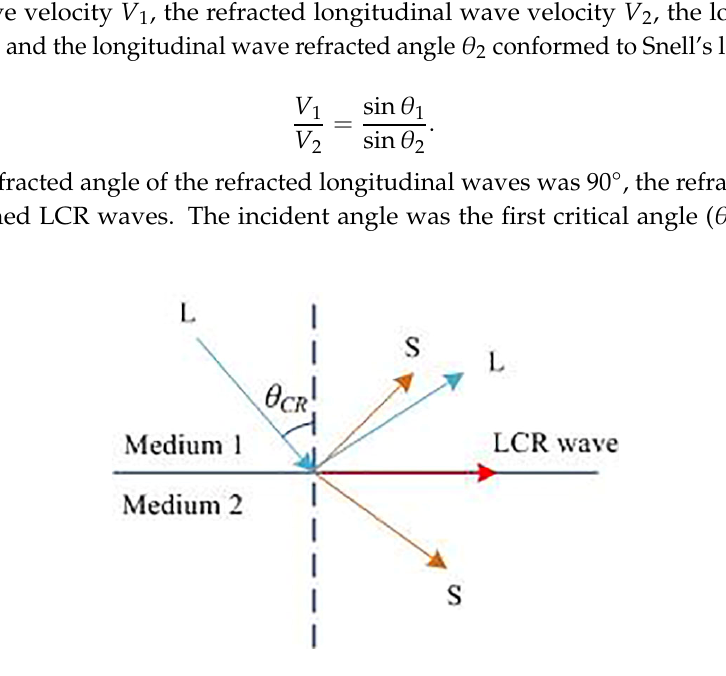
Figure 1. The mechanism of ultrasonic longitudinal critically refracted (LCR) wave.